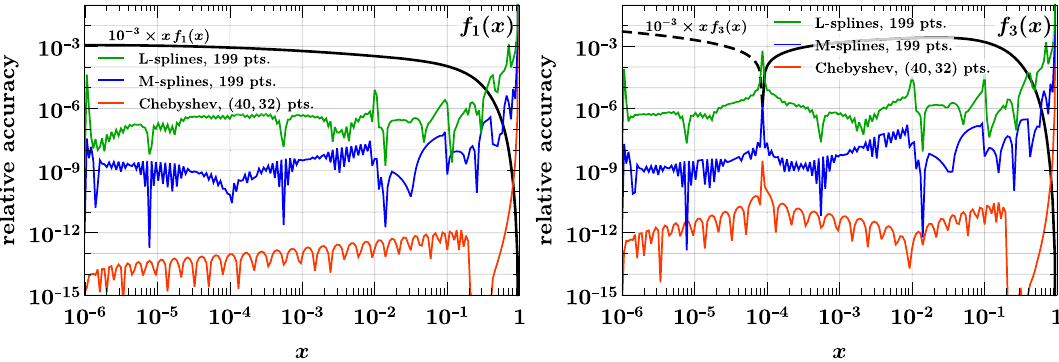
the grid [ 10 − 6 , 0 . 2 , 1 ] ( 32 , 32 ) , which has n pts = 63. Here and in similar plots, the exact result that is being interpolated is shown in black (and dashed where the result is negative)